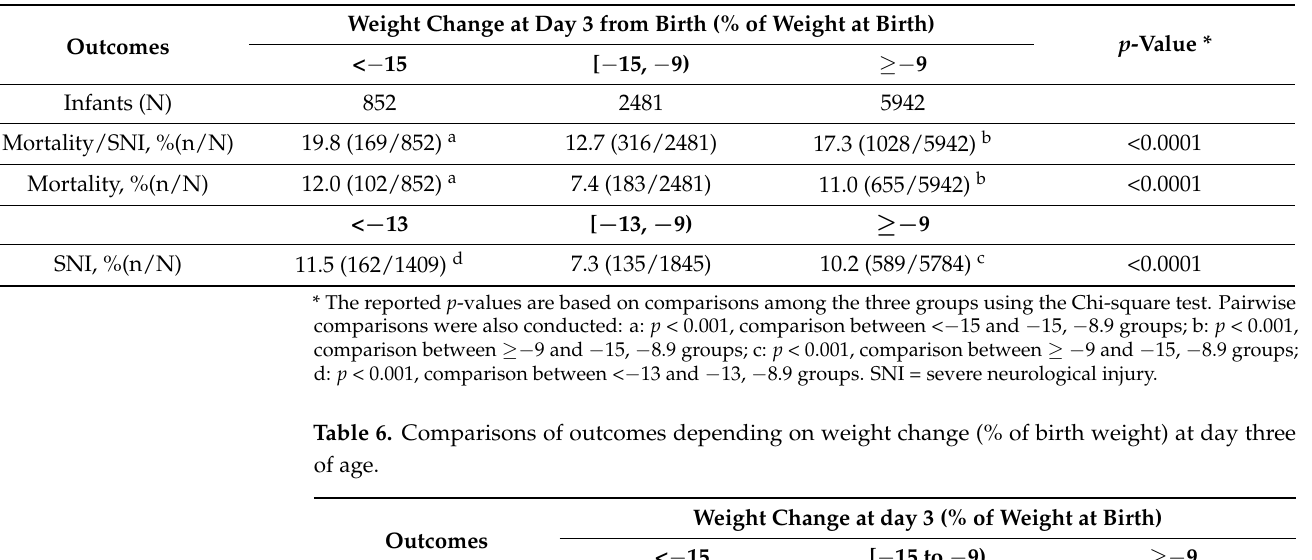
Table 5. Comparisons of outcomes (frequency and percentage) depending on weight change (% of birth weight) at day three of age.